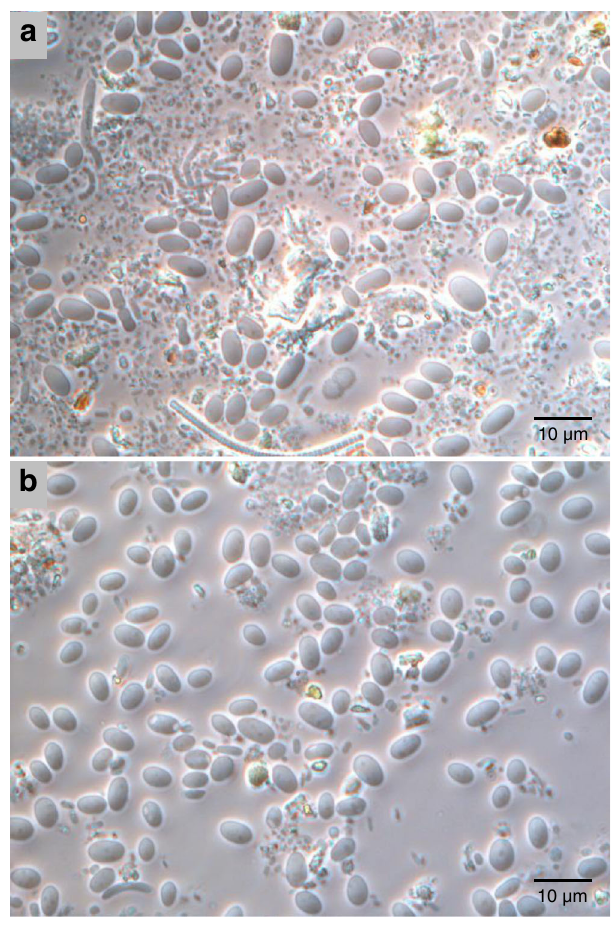
Fig.2|Phasecontrastimagesofenriched Quinella -likecells.a Supernatantafter the fi rst fi ltration through 23- µ m pore size nylon mesh and subsequent cen- trifugation (100× g ). b Quinella -like cells after the enrichment protocol was com- pleted. The scale bar indicates a distance of 10 μ m. Panel b was from sample 3, which was prepared from rumen contents ( a ), and similar results were observed withsamples1and2.Thisphotowasselectedtoillustratetheenrichmentoutcome. Untreated samples from 12 sheep looked similar to panel ( a